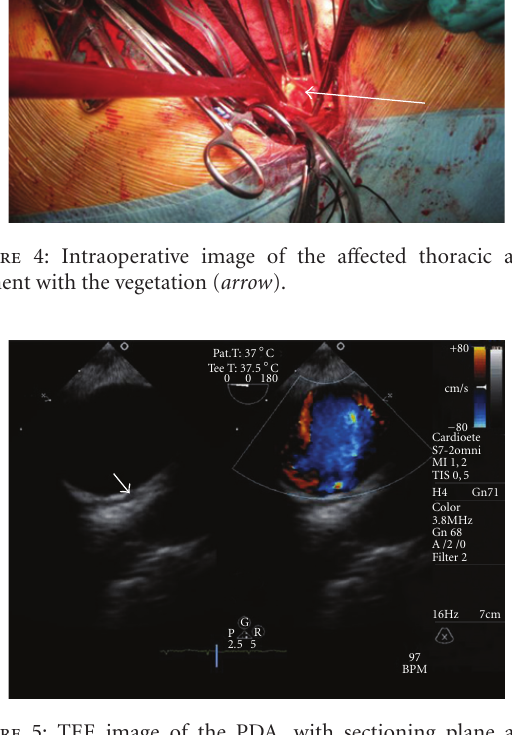
Figure 5: TEE image of the PDA, with sectioning plane at 0 ◦ , performed 4 weeks after surgery and before the discharge, showing the aortic conduit ( arrow) ; (left) with a normal colour doppler flow